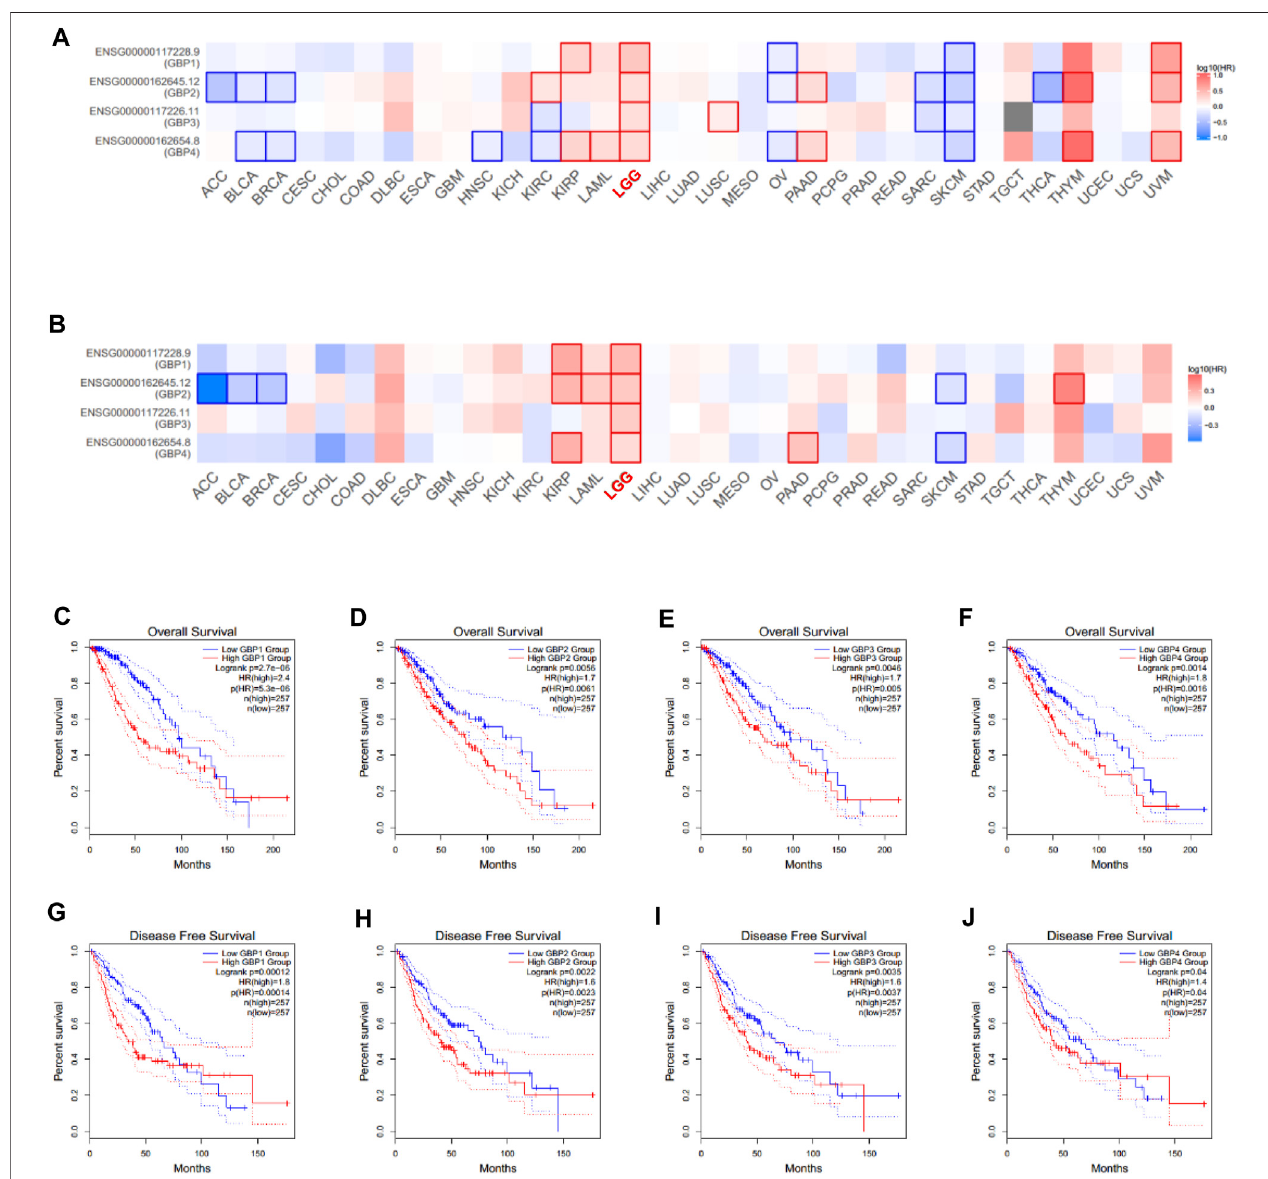
FIGURE 3 | Prognostic value of GBP1/2/3/4 in LGG patients (GEPIA). Survival signi fi cance maps of GBP1, 2, 3, 4 in pan-cancer perspective showed the (A) over survivaland (B) disease-freesurvivalanalysisresultsbasedontheCoxproportionalhazardratio(HR)(theredandblueblocksdenotehigherandlowerrisks,respectively; the rectangles with frames indicate signi fi cant unfavorable and favorable results). The overall survival curve of (C) GBP1 (D) GBP2, (E) GBP3, and (F) GBP4 in LGG patients. The disease-free survival curve of (G) GBP1 (H) GBP2, (I) GBP3, and (J) GBP4 in LGG patients.